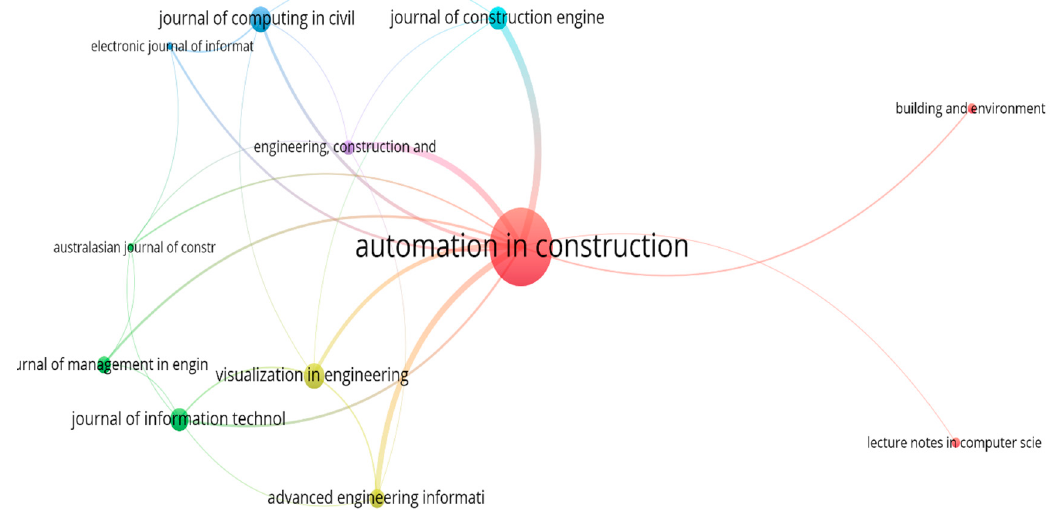
Figure 4. Network of published journals.